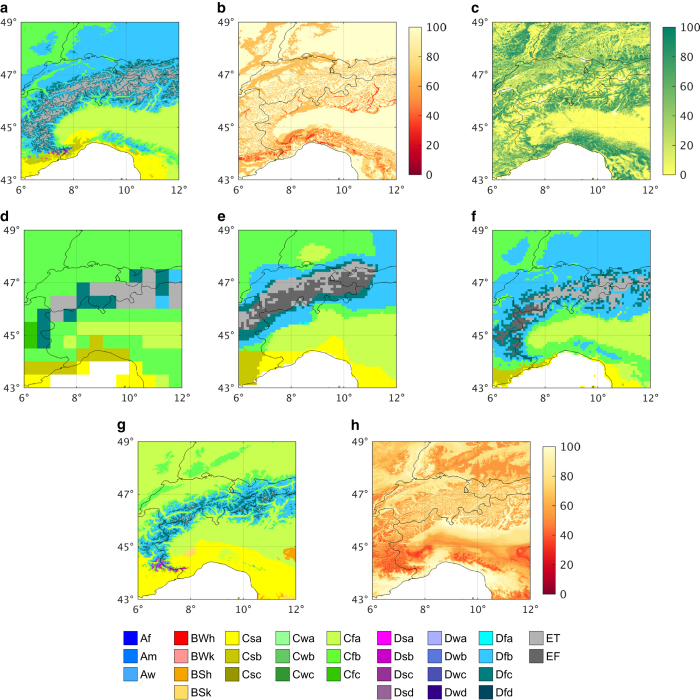
Köppen-Geiger classifications, and associated maps, for the European Alps.Part (a) present-day results from our study (1980–2016); (b) confidence levels associated with our present-day map; and (c) forest cover map36 (2000). Historic Köppen-Geiger classification maps for the three previous studies are provided as: (d) Kottek et al.20 (1951–2000); (e) Peel et al.21 (1916–1992); and (f) Kriticos et al.22 (1960–1990). Our future Köppen-Geiger map (2071–2100) is presented in (g) and the corresponding confidence map in (h). The representative period of each map is listed in parentheses. Thin black lines are country borders and the unmapped white area is part of the Mediterranean Sea.